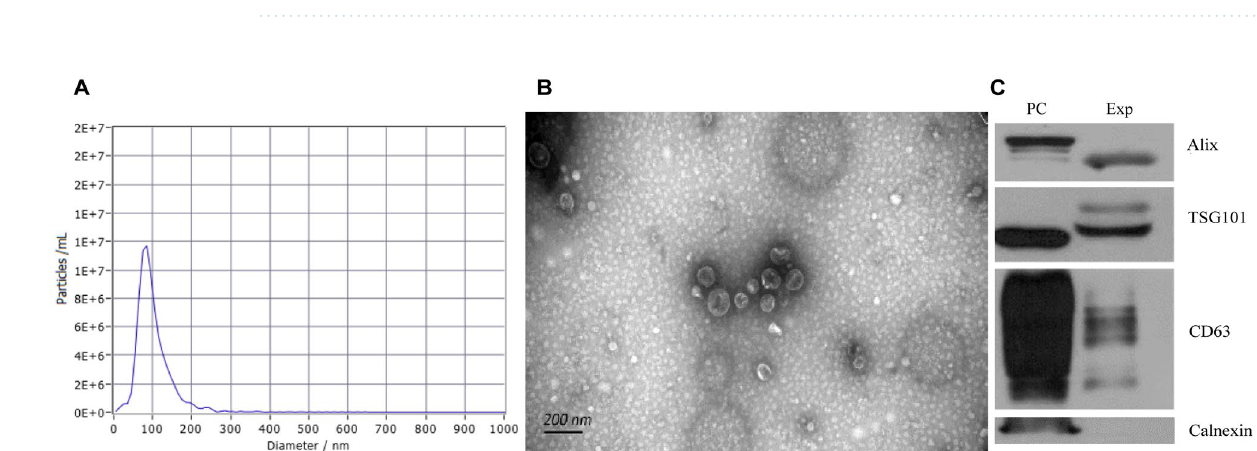
Table 2. Behavioral characteristics of study participants. M mean, SD standard deviation, VAS Visual- Analogue Craving Scale, MDPs methamphetamine-dependent patients, HDPs heroin-dependent patients, HCs healthy controls.